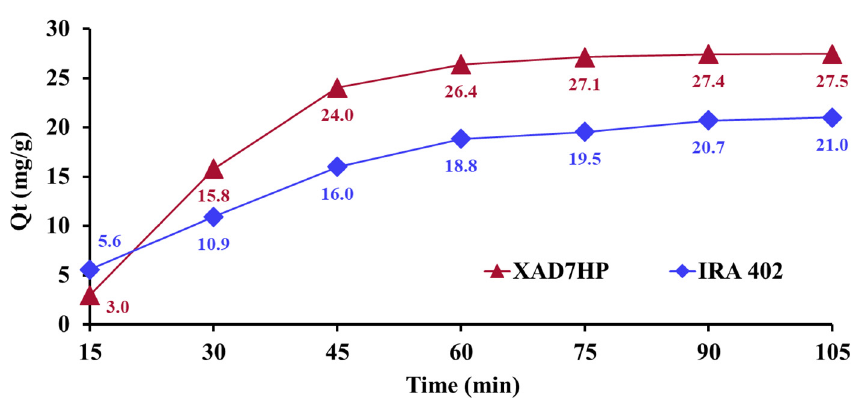
Figure 2. Influence of interaction time on adsorption of DR 23 on IRA 402 (Cl − ) and